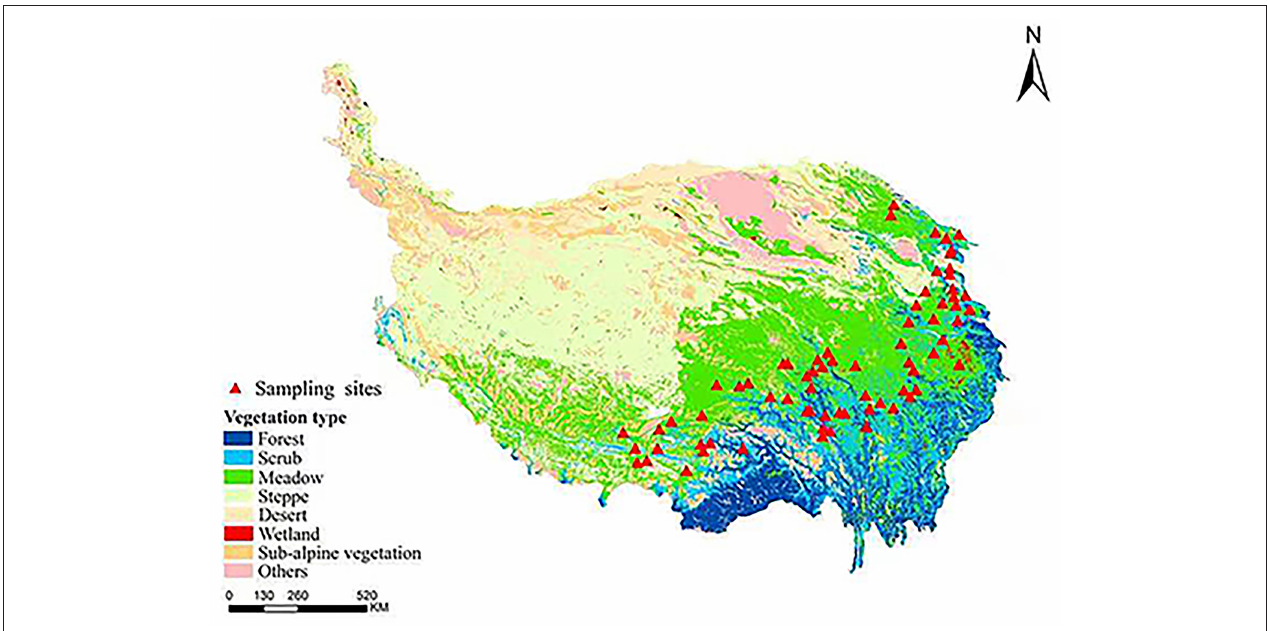
FIGURE 1 | Geographical distribution of the regions of A. tanguticus .